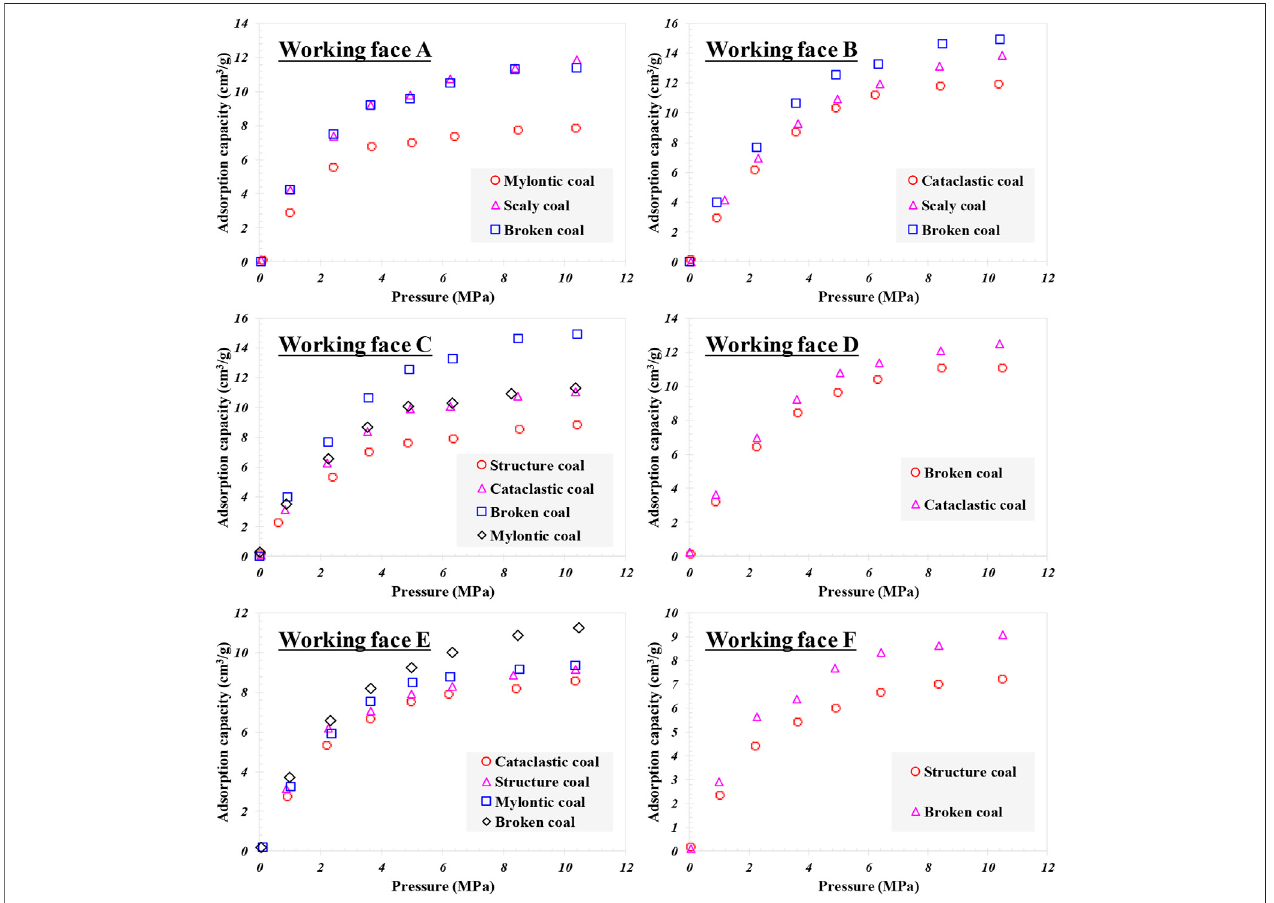
FIGURE 1 | Distribution map of MRE to adsorption model of sheared